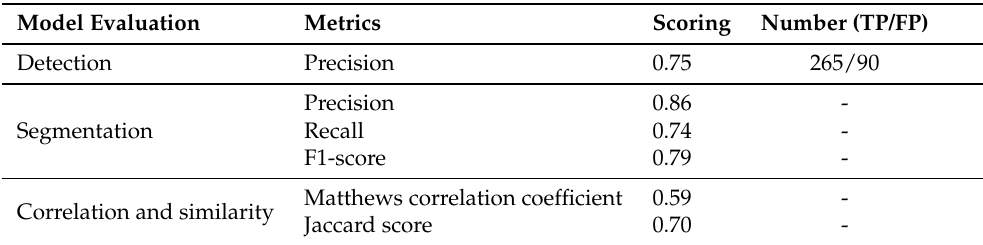
Table 2. Performance of the algorithm in the testing